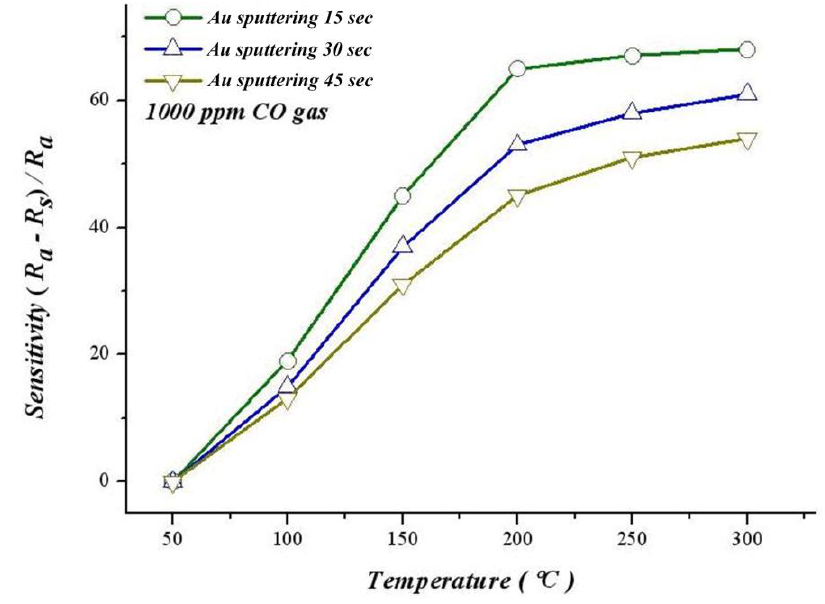
Figure 16. Relation between temperature and sensitivity during different gold deposition